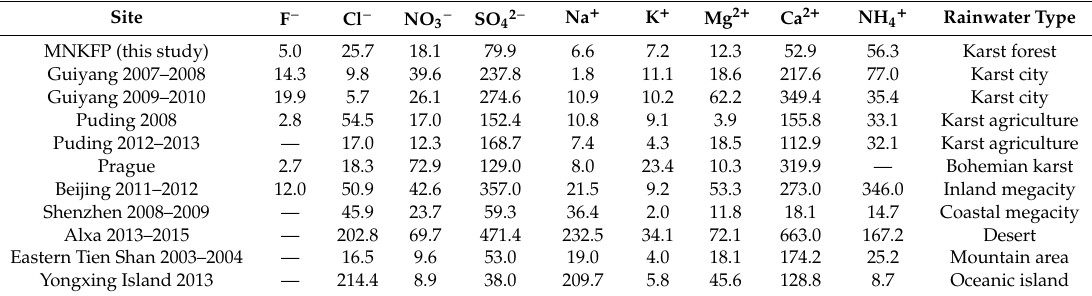
Table 1. Comparison of ion concentration (in µ eq L − 1 ) of rainwater in the MNKFP and other published